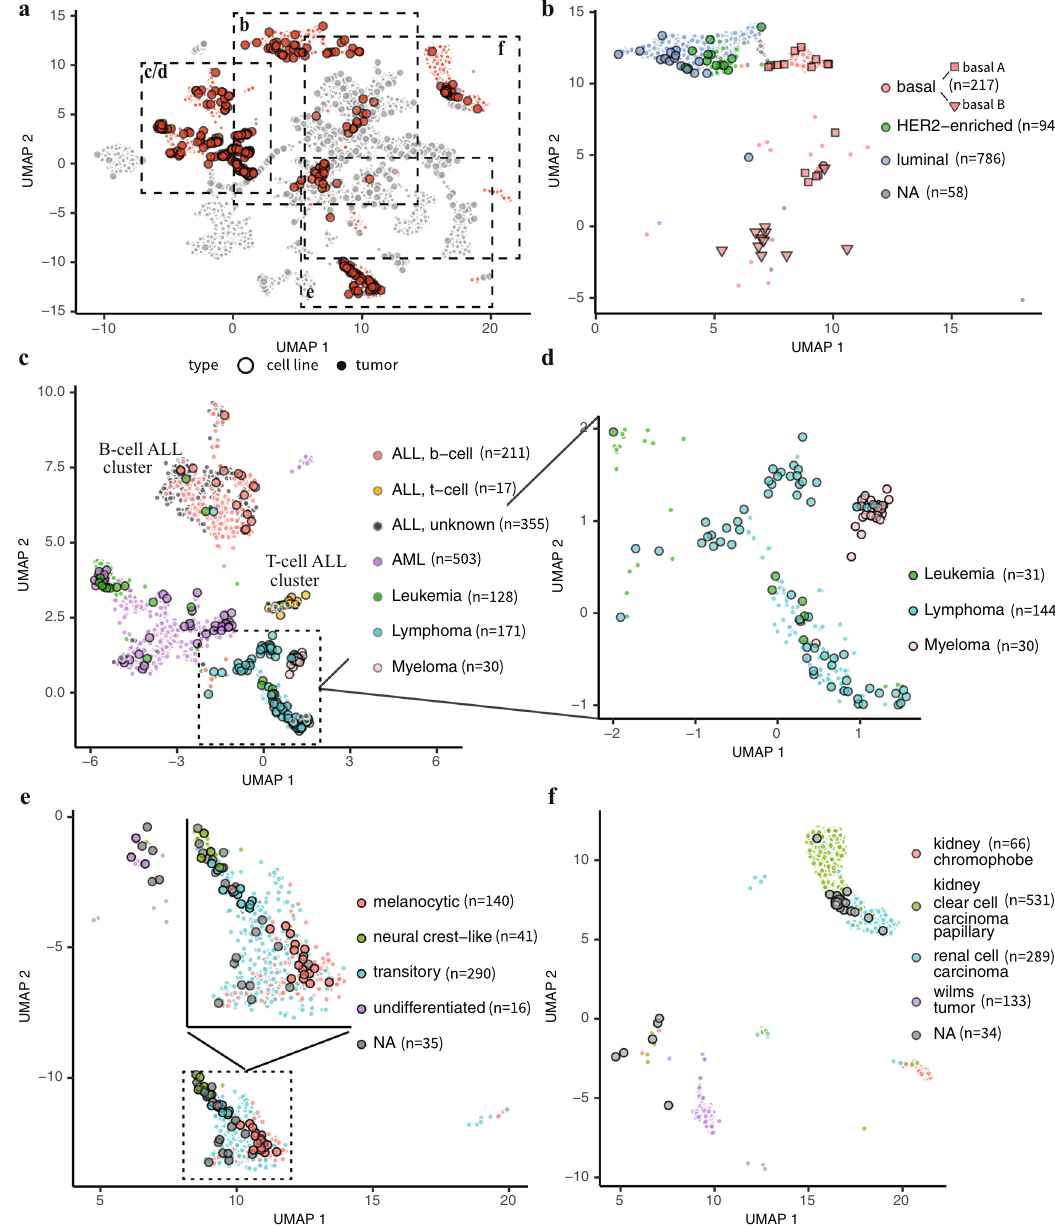
Fig. 4 Subtype alignment. a UMAP 2D projection of the Celligner-alignment with breast, kidney, hematopoietic, and skin samples highlighted in red. b Luminal and basal breast cancer subtypes cluster together for cell lines and tumors ( n = 56 cell lines, n = 1,099 tumors). c Leukemia tumor and cell lines co-cluster in the aligned data by subtype ( n = 197 cell lines, n = 1,218 tumors). d Myeloma cell lines cluster near the hematopoietic samples, but distinct from the tumors ( n = 96 cell lines, n = 109 tumors). e Skin cancer melanocytic, transitory, neural crest-like, and undifferentiated subtypes align between cell lines and tumors ( n = 63 cell lines, n = 459 tumors). f Kidney chromophobe tumor samples do not cluster with any cell lines ( n = 34 cell lines, n = 1019